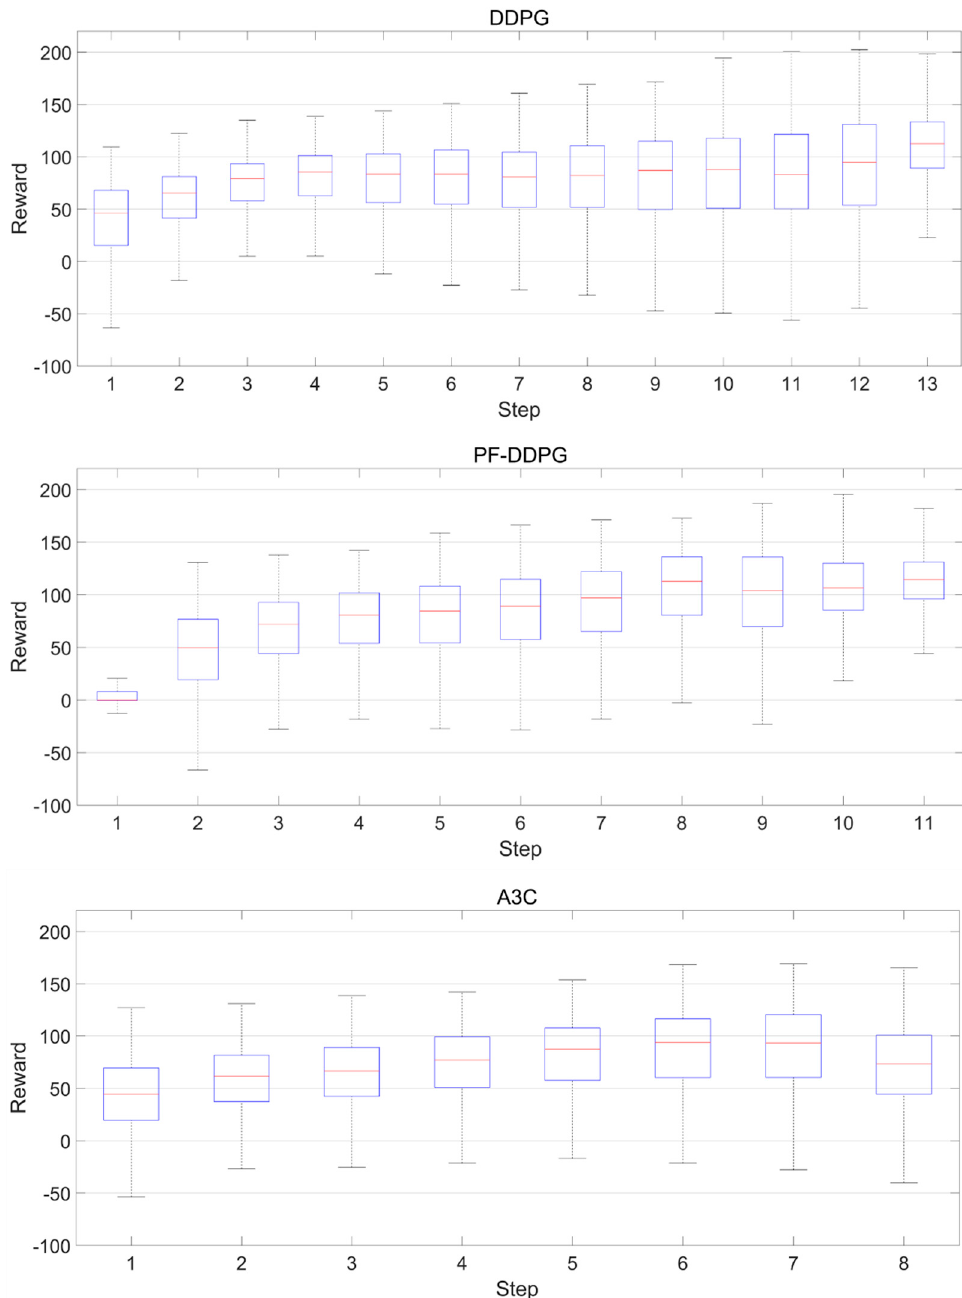
Figure 6. Moving averages of the reward values.